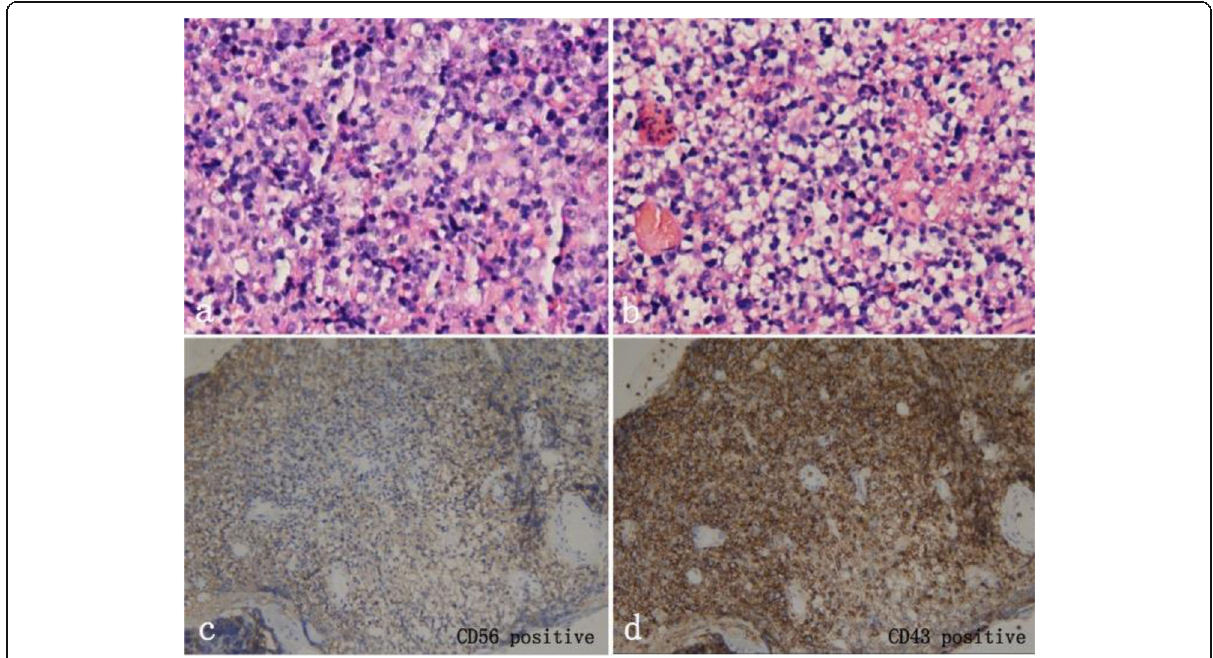
Fig. 7 Histological and immunohistochemical images of conjunctiva biopsy. Immunohistology was positive for CD3, CD56, CD43, CD2, Ki67 85%,